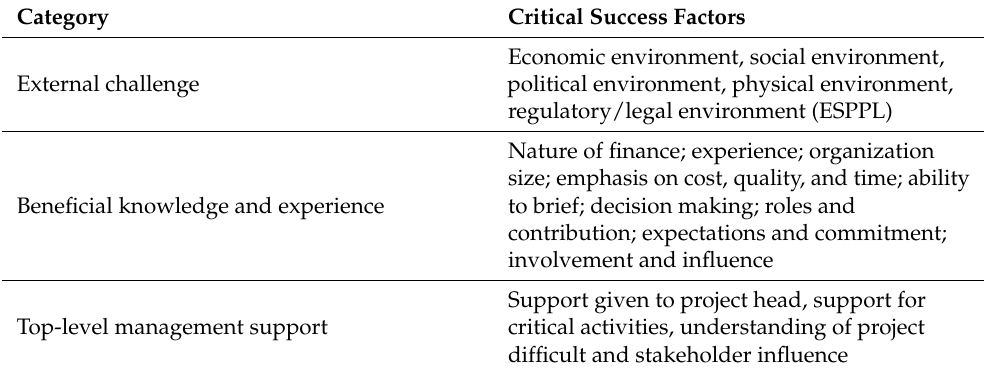
Table 1. CSF fields of